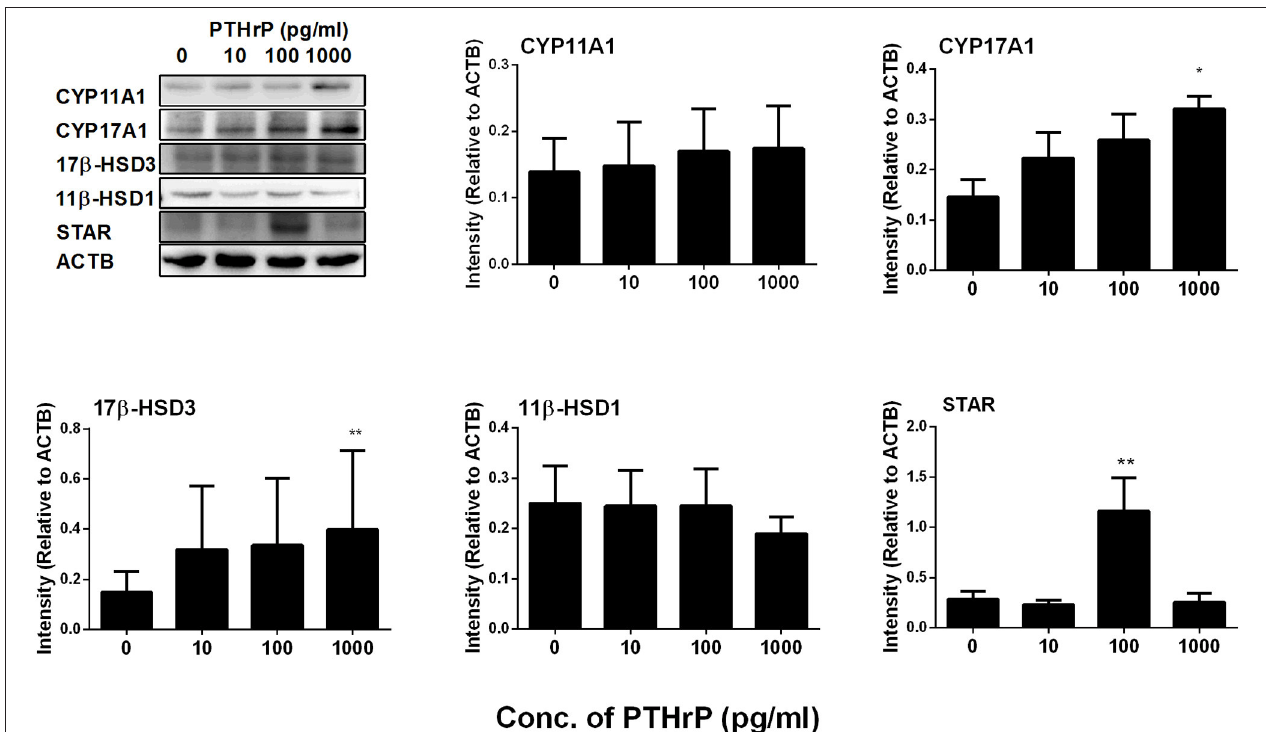
FIGURE 3 | PTHrP up-regulates the expression levels of some Leydig cell-specific proteins in vitro . The protein levels of CYP11A1, CYP17A1, 17 β -HSD3, 11 β -HSD1, and STAR were analyzed by Western blot in the seminiferous tubules treated with 0, 10, 100, and 1,000pg/ml PTHrP for 14 days. Mean ± SEM, n = 3, * P < 0.05, ** P < 0.01 when compared to the